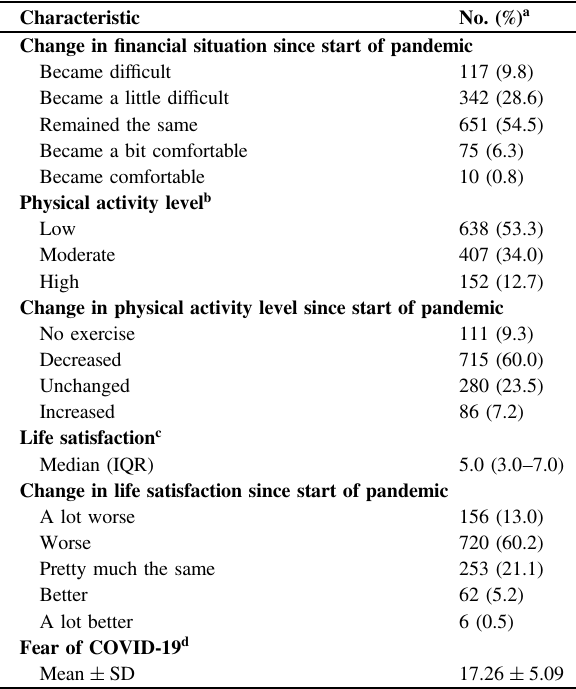
Table 2 Impact of the COVID-19 Pandemic on Daily Life and Sense of